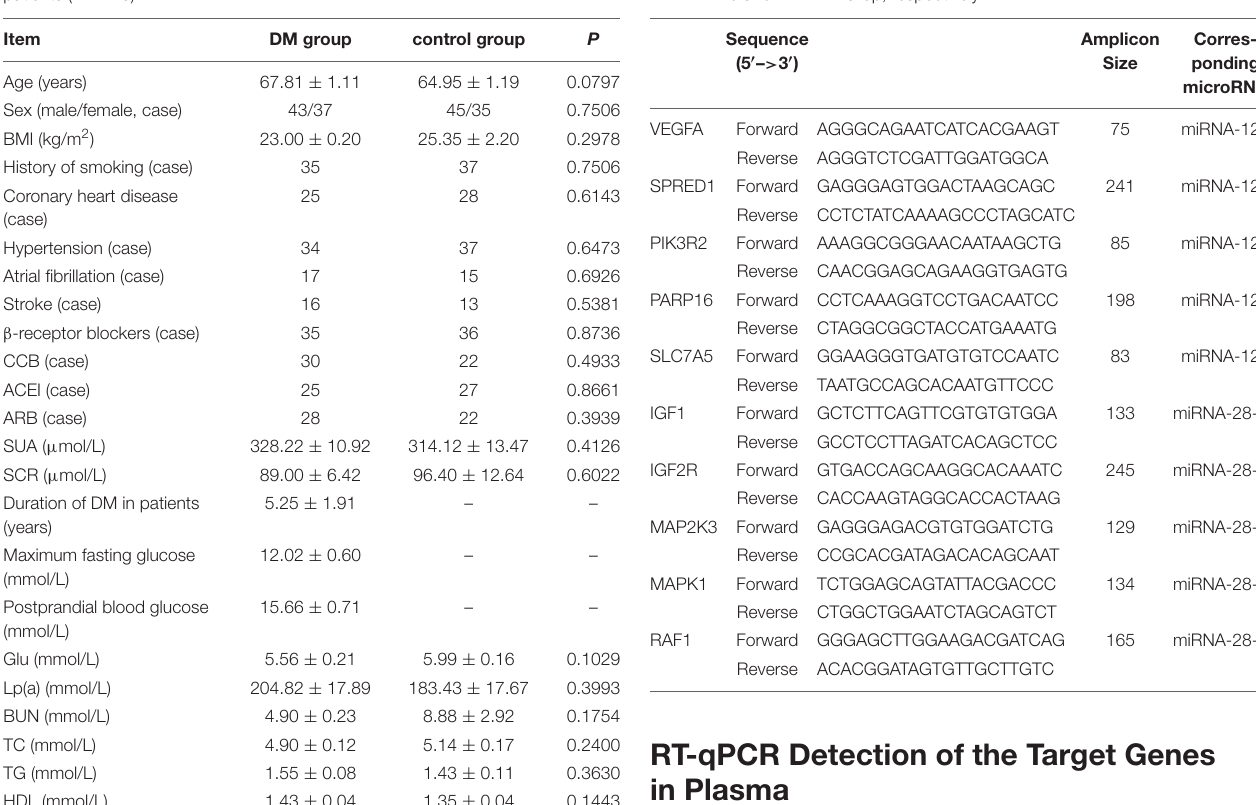
TABLE 1 | Basic medical history and biochemical examination of two groups of patients ( n = 120).